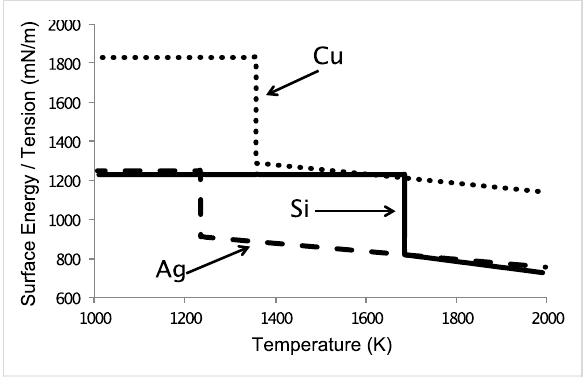
Figure 5: Graph of the dependence of the surface tension of Si, Cu, and Ag with temperature.